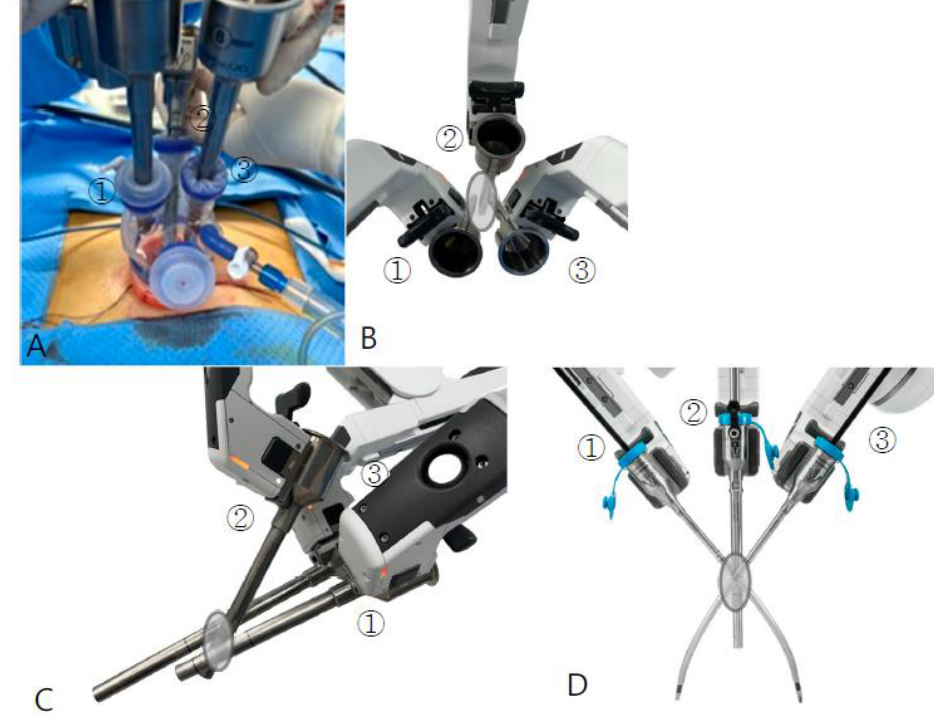
Figure 1. Placement of cannulas for C-RSSM ( A – C ) and RSSM ( D ); the gray circle represents a single incision port. 1 (cid:13) , 2 (cid:13) and 3 (cid:13) are connected to arm 1, arm 2, and arm 3. ( A , B , D : View from the patient’s head, C : View from beside the patient); C-RSSM, Coaxial-robotic single-site myomectomy; RSSM, robotic single-site